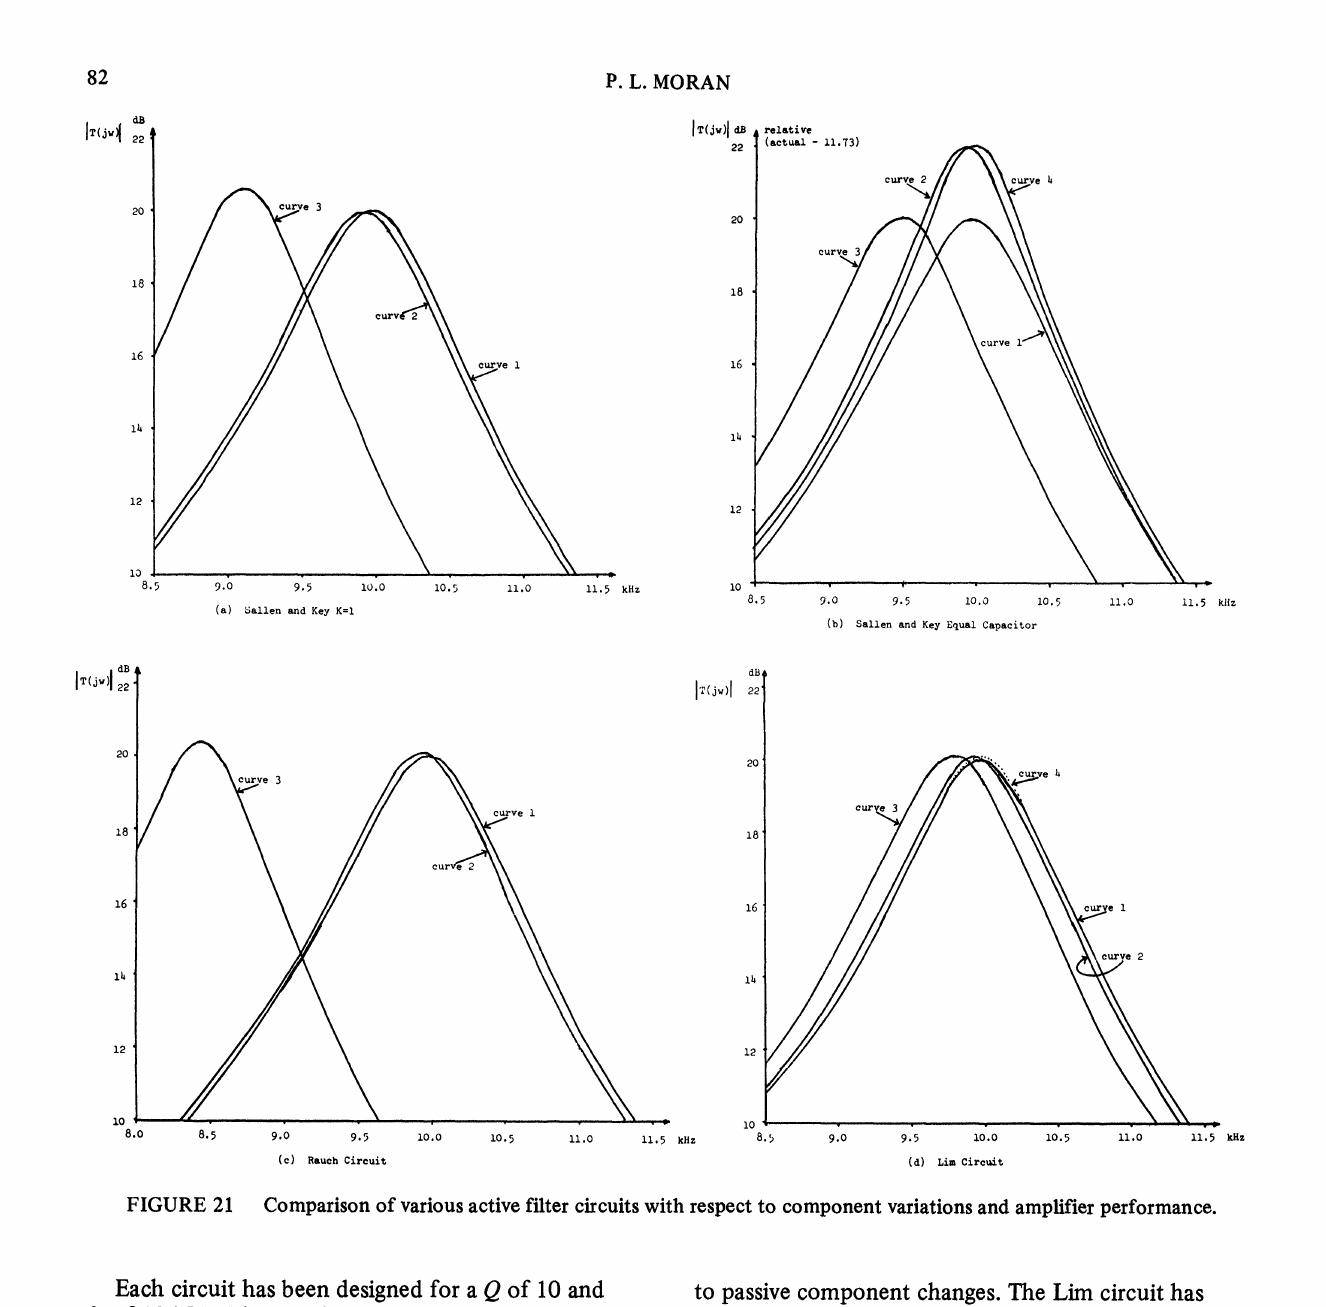
Comparison of various active filter circuits with respect to component variations and amplifier